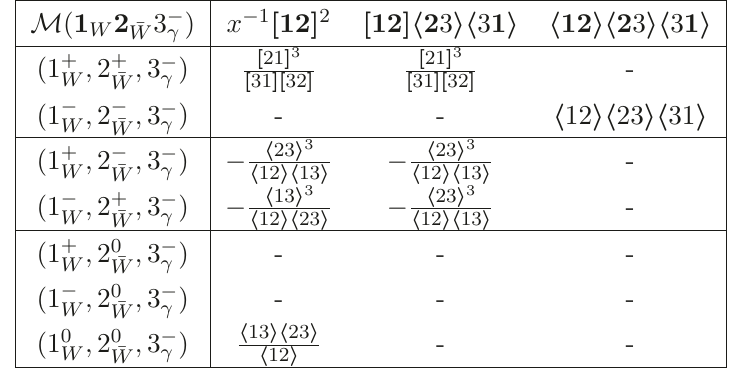
( 1 W 2 ¯ 3 − ) amplitude. W γ M